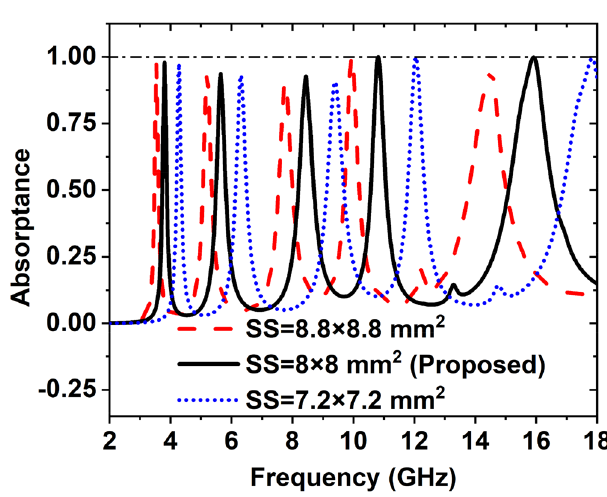
Figure 17. Effect of size of the substrate on the absorption peaks and resonance frequency.